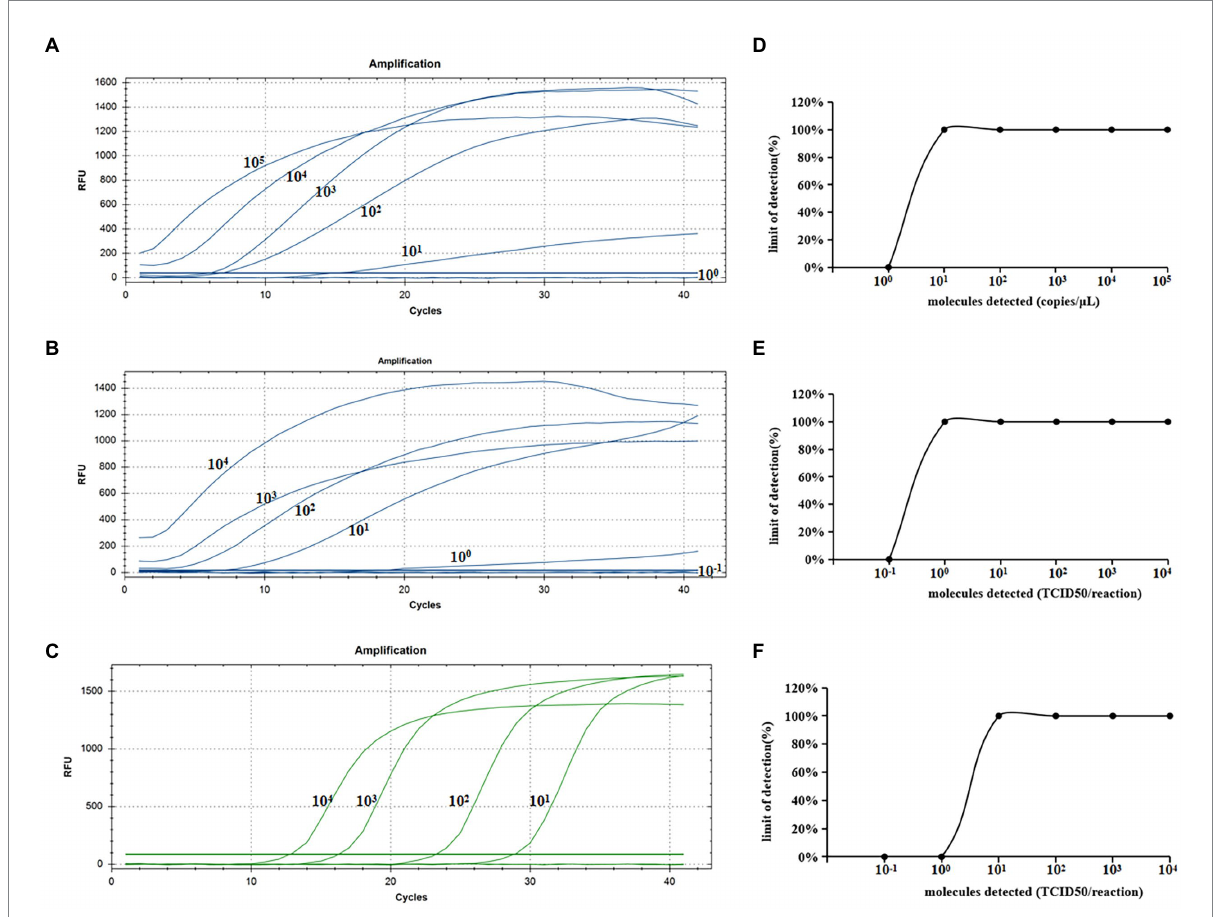
FIGURE 4 Sensitivity analysis of the real-time RAA and real-time qPCR assay for CIAV. (A) The standard plasmid of CIAV VP2 was detected at 10 5 , 10 4 , 10 3 , 10 2 , 10 1 , and 10 0 copies/ μ L, repeated five, respectively. Ten copies of DNA can be detected per reaction of the real-time RAA assay. (B) The real-time RAA assay detected CIAV TCID50 10 − 1 to 10 4 per reaction repeated five, respectively. (C) The real-time qPCR assay detected CIAV TCID50 10 − 1 to 10 4 per reaction repeated five, respectively. (D) The data of five runs from plasmid standards by analyzing real-time RAA assay. (E) The data of five runs from CIAV DNA by analyzing real-time RAA assay. (F) The data of five runs from CIAV DNA by analyzing real-time qPCR assay. CIAV, Chicken Infectious Anemia Virus; qPCR, quantitative polymerase chain reaction assay; RAA, recombinase-aided amplification